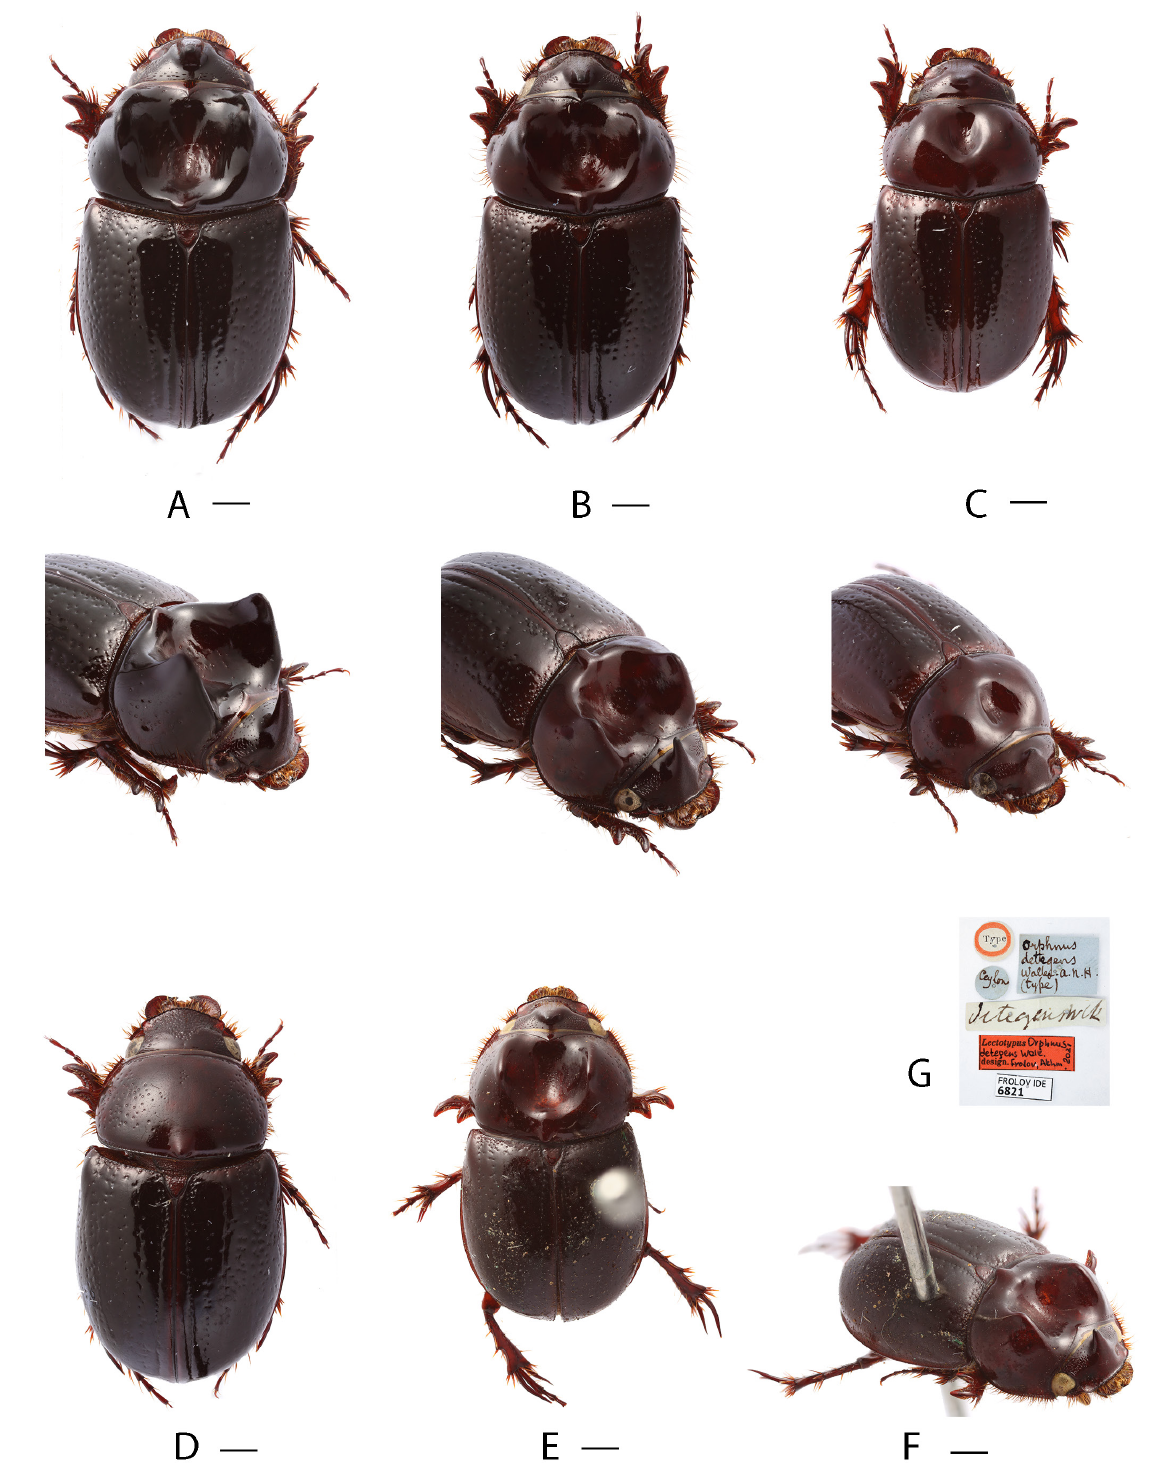
Fig. 2. Orphnus mysoriensis Westwood, 1845. A–C . ♂ (NHMB). D . ♀ (NHMB). E–G . Lectotype of Orphnus detegens Walker, 1859, ♂ (BMNH). A–F . Habitus in dorsal view. G . Labels. Scale bars = 1.0